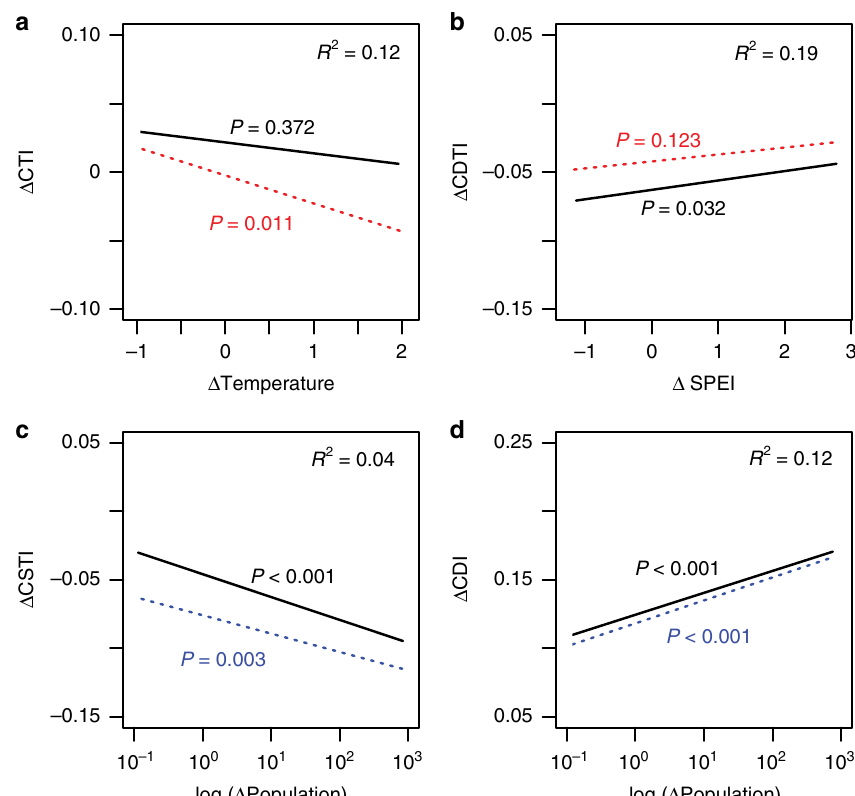
Fig. 3 Relationships between changes in functional composition and potential predictors. Linear mixed models: a Δ CTI with Δ Temperature, b Δ CDTI with Δ SPEI and c , d Δ CSTI and Δ CDI with log-transformed Δ Population. Black lines and text show effects estimated by models with single predictors, while colored lines and text show effects after controlling for changes in other indices (see Methods). Red lines and text show effects after controlling for changes in disturbance-related indices ( Δ CSTI and Δ CDI), while blue lines show effects after controlling for changes in climate-related indices ( Δ CTI and Δ CDTI). P values are shown for each line and the conditional R 2 values of single-predictor models are shown in the upper right corners. CTI community temperature index, CDTI community drought tolerance index, SPEI standardized precipitation evapotranspiration index, CSTI community shade tolerance